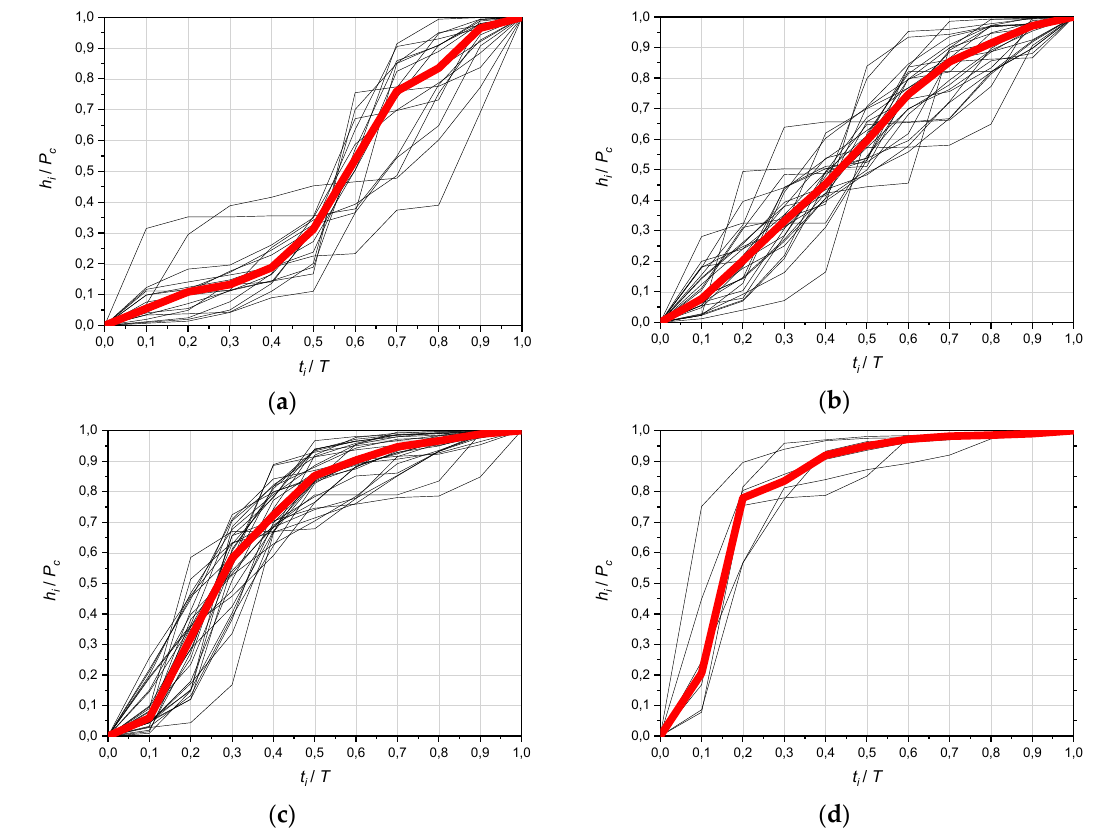
Figure 8. Dimensionless rainfall mass curves with a median for four clusters separated by the k -means method: ( a ) Cluster No. 1, ( b ) cluster No. 2, ( c ) cluster No. 3, and ( d ) cluster No. 4.